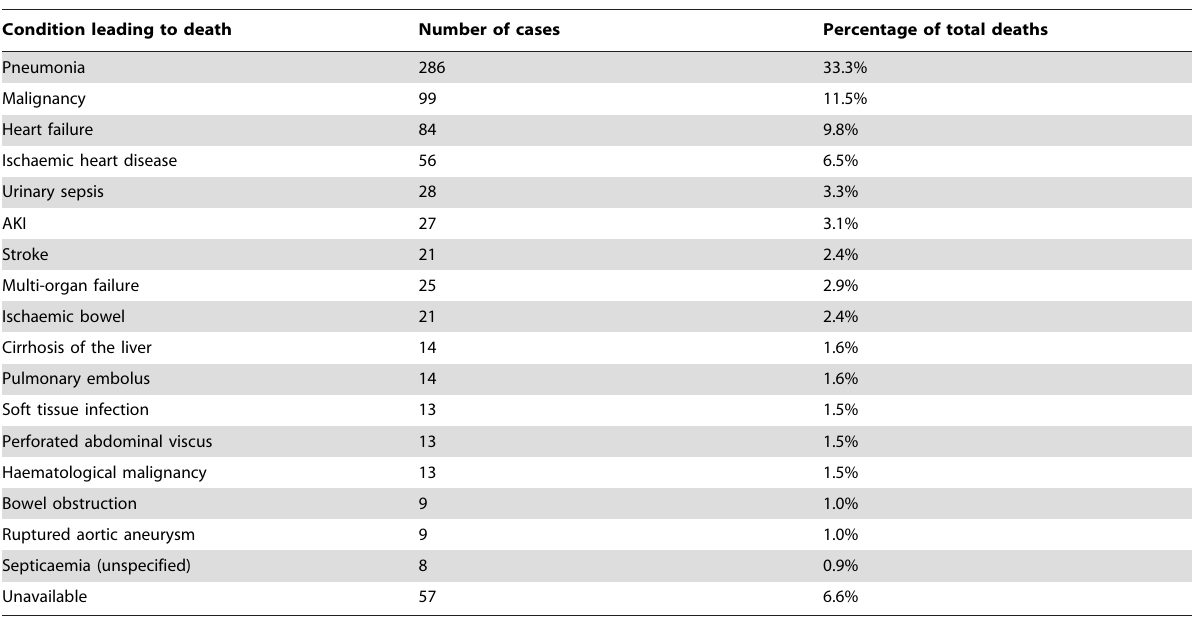
Table 1. Table of the most frequent primary causes of death.